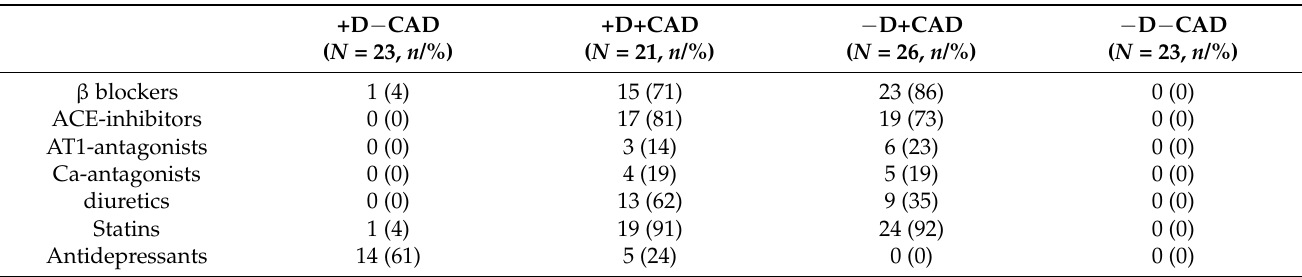
Table 3. Summary of the